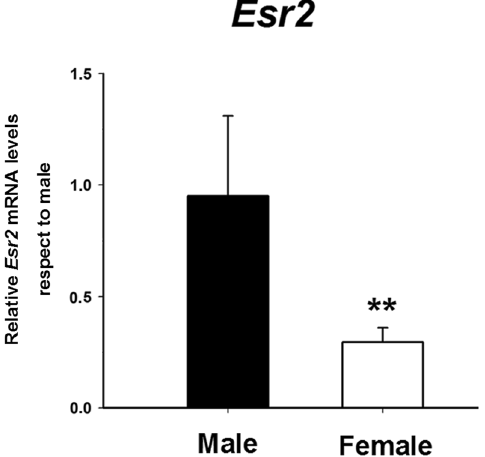
Figure 7. Expression of ER β mRNA ( Ers2 ) in male and female primary amygdala neuronal cultures from CD1 mouse embryos. Male cultures had higher expression of Ers2 than females. ** p ≤ 0.01. Bars indicate mean + SEM. n = 4–6 independent